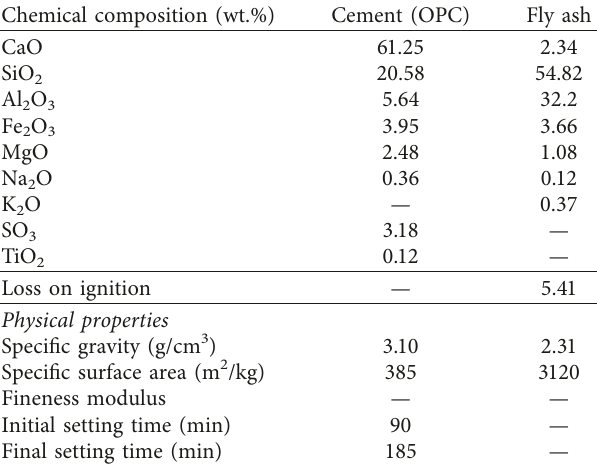
Table 1: Properties of OPC and fly ash. Chemical composition (wt.%)